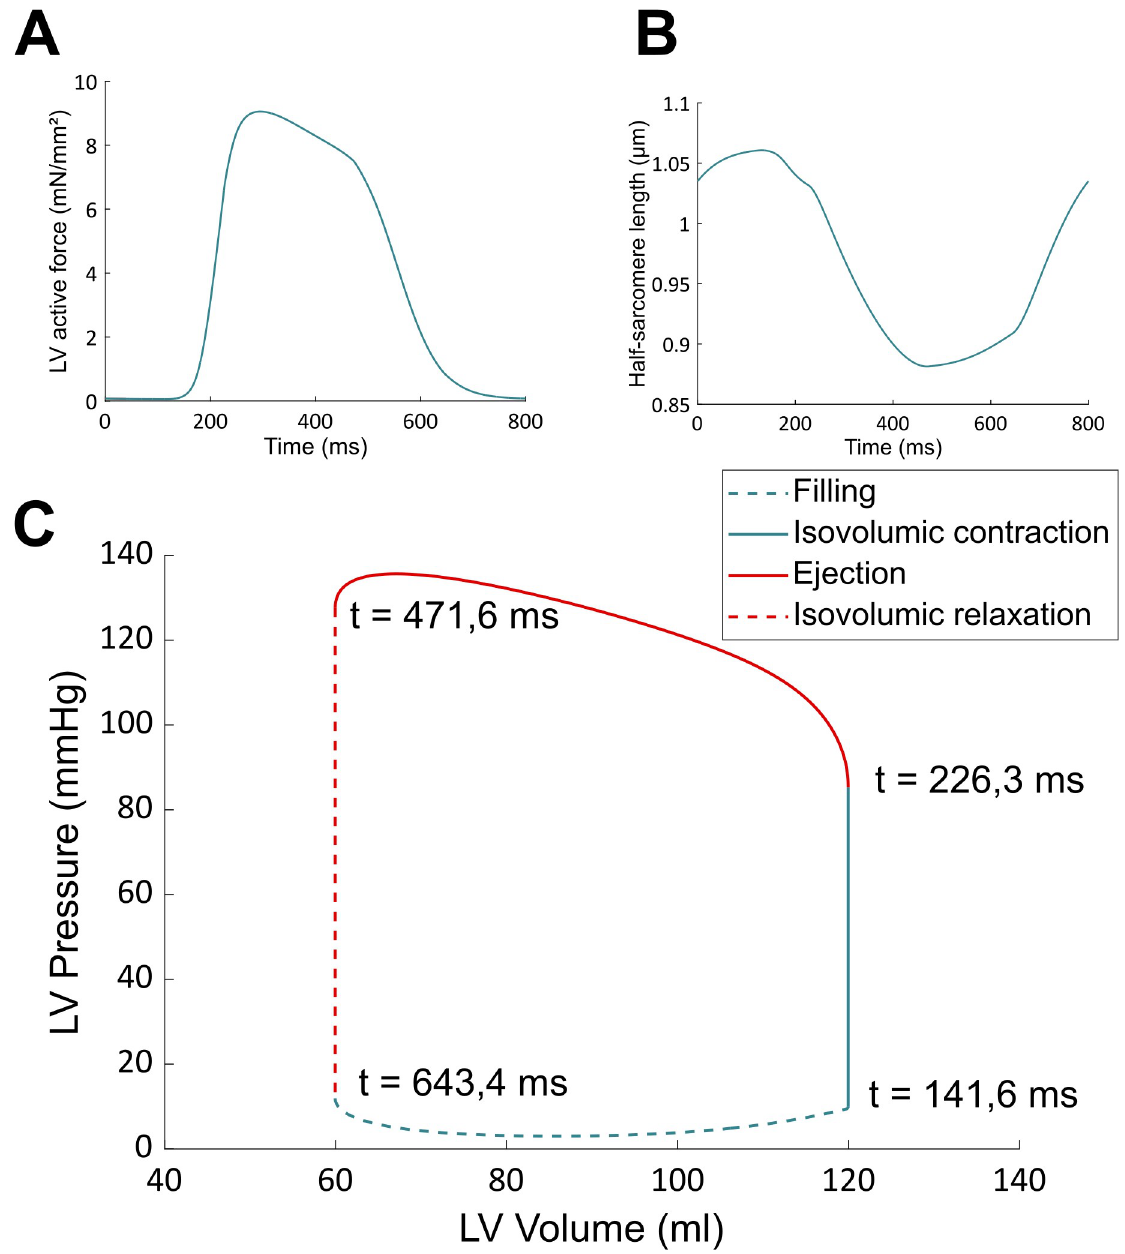
Fig 5. Baseline results obtained with the CVS model. These curves, that describe normal (healthy) hemodynamical conditions, are similar to Fig 5 from [49]. Time values on the PV loop indicate the beginning of each phase of the cardiac cycle for an 800 ms